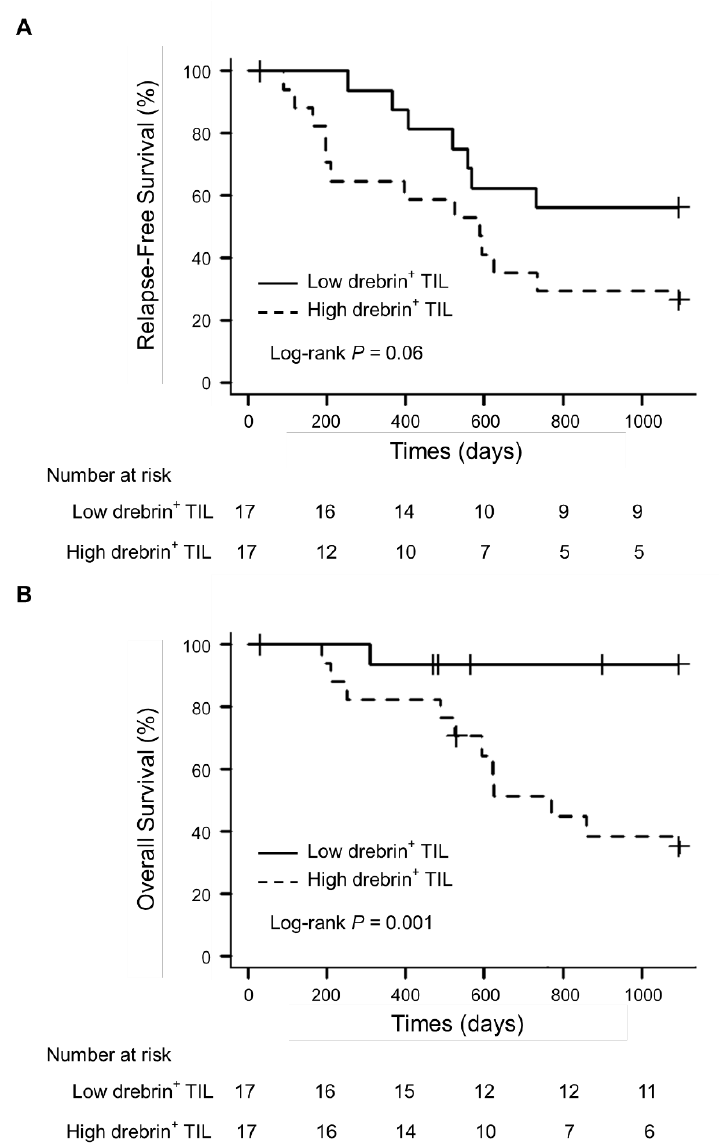
Figure 3. Association of drebrin-expressing TILs in tumor cell nests and survival outcomes. ( A ) Relapse-free survival of patients with high and low infiltrations of drebrin + TILs. ( B ) Overall survival of patients with high and low infiltrations of drebrin + TILs. TILs, tumor-infiltrating lymphocytes.